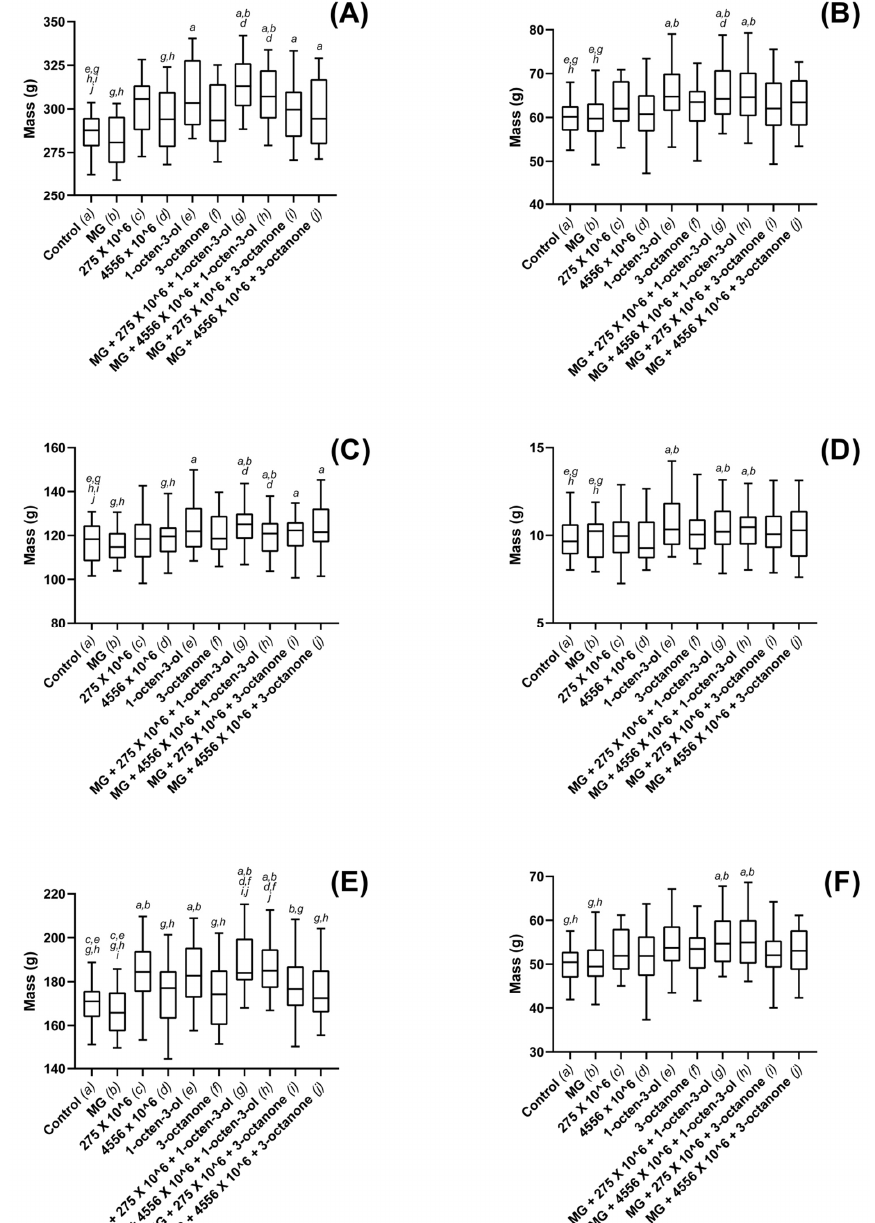
Figure 4. Plant growth metrics for strawberry plants exposed to M. brunneum , M. brunneum -derived VOCs and hydrogels. ( A ) whole-plant fresh mass, ( B ) whole-plant dry mass, ( C ) fresh shoot mass, ( D ) dry shoot mass ( E ) fresh root mass and ( F ) dry root mass, recordings for plants grown in composts treated with hydrogels (MG), M. brunneum strains: V275 or 4556, 1-octen-3-ol, 3-octanone or combinations thereof. All M. brunneum applications were standardized at 1 × 10 6 conidia g − 1 compost, and all VOCs were added at a rate of 1 µ L 100 g − 1 compost. Hydrogels were added according to manufacturer specification. Controls were grown in untreated composts. Plants were grown in a glasshouse maintained at 25 ± 2 ◦ C for a total of six weeks. Controls were exposed to compost media without additional treatment. Figure display’s minimum, 1st quartile, median, 3rd quartile and maximum measurements within the treatment groups. Significant results denoted between treatments using letters ( a – j ) above each boxplot; where denotation letters are absent, no significant differences were detected between treatments. Key: 275— M. brunneum (Strain: